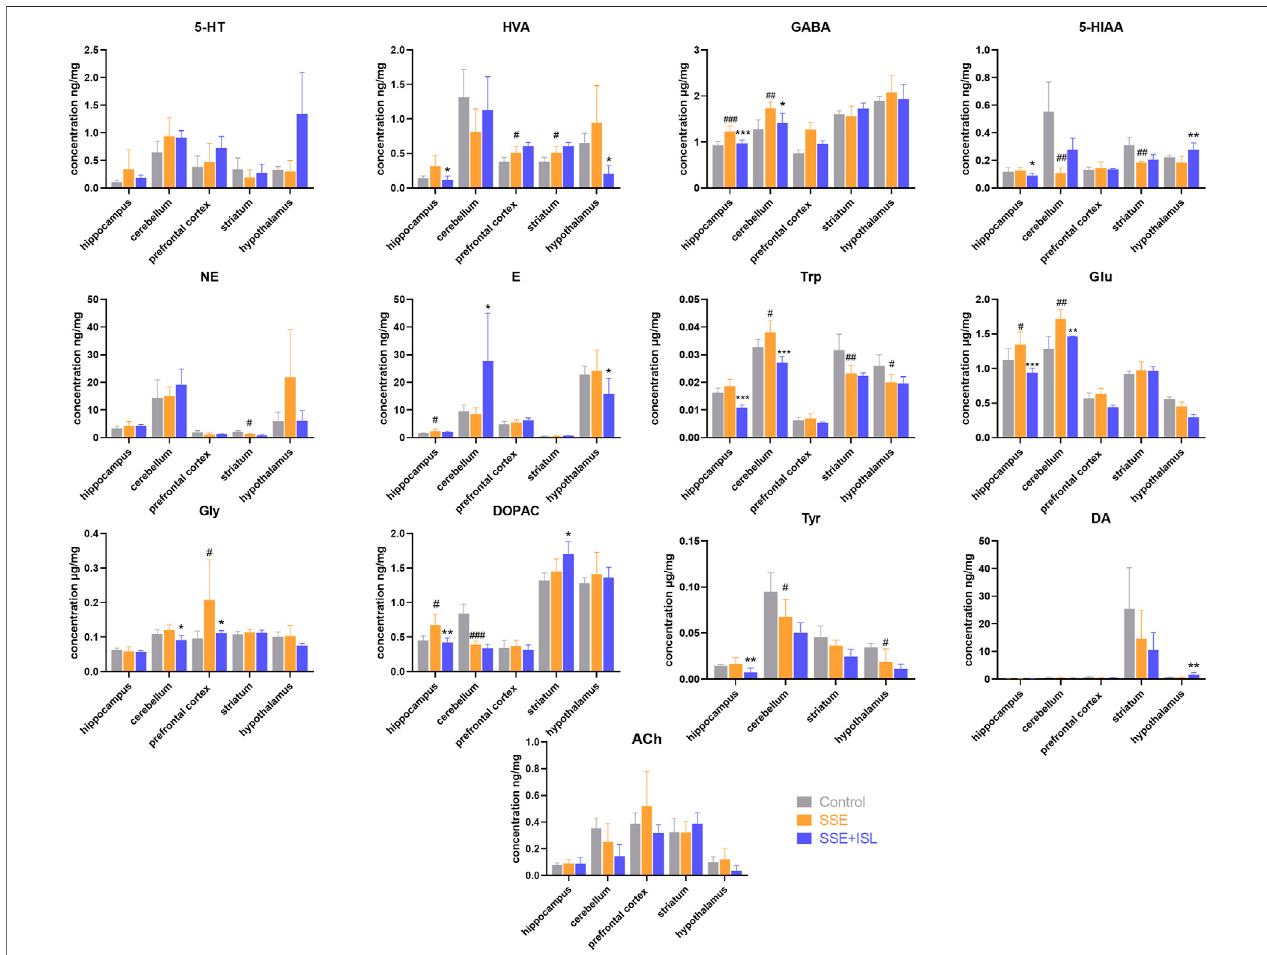
FIGURE 3 | Determinations results of rat brain samples in different regions collected from different groups. Each value was represented as mean ± SD (standard deviation). ### p < 0.001, ## p < 0.01, and # p < 0.05 (SSE group vs. Control group); *** p < 0.001, ** p < 0.01, and * p < 0.05 (SSE + ISL group vs. SSE group).